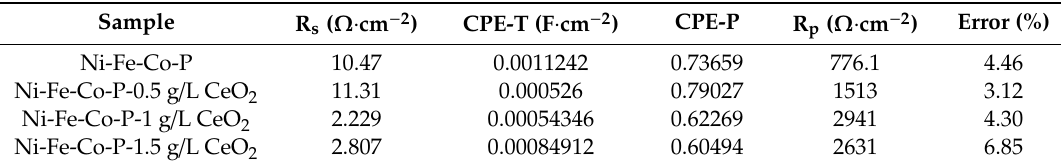
Table 5. Equivalent circuit diagram parameter